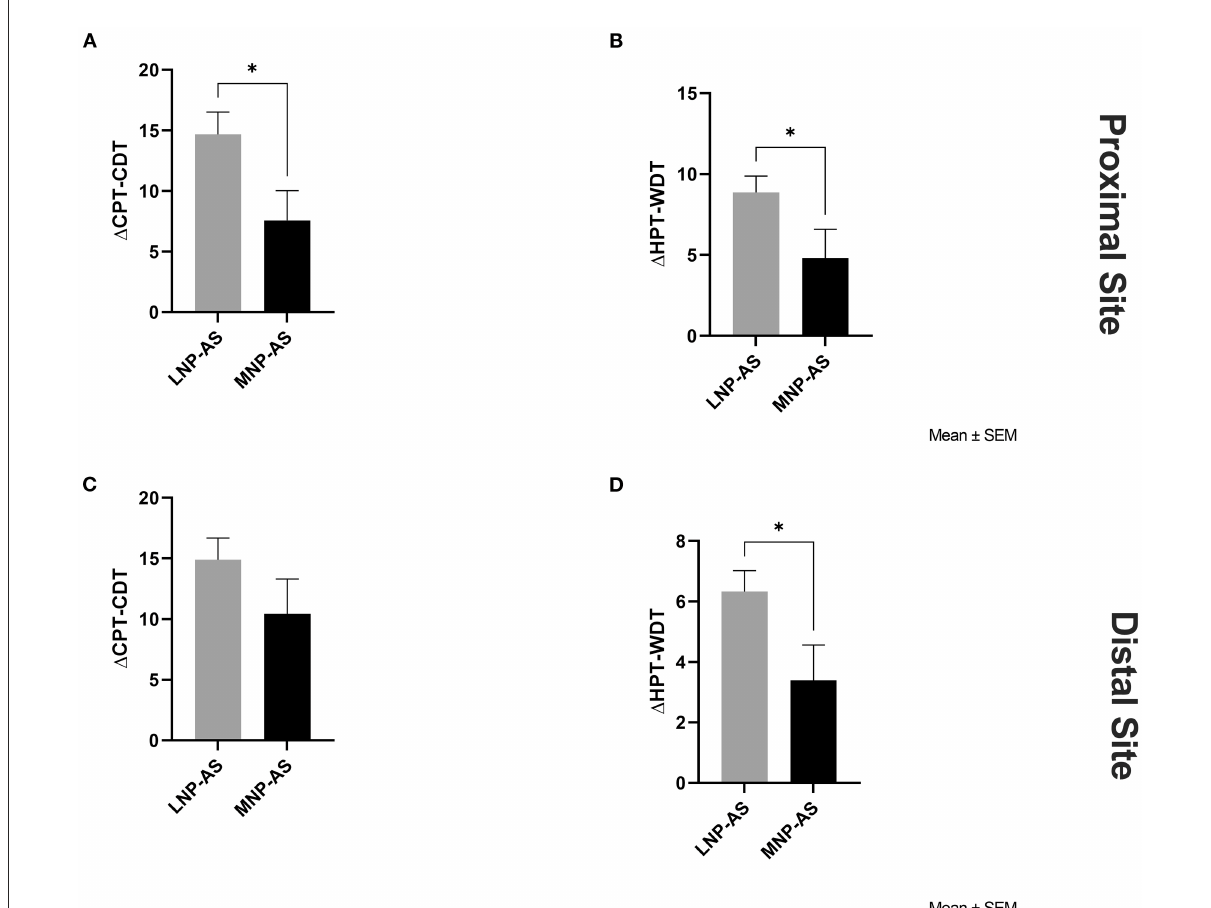
FIGURE2 Thermal somatosensory function obtained from QST. Significant group differences were found on the proximal site with respect to: (A) 1 CPT-CDT (delta cold pain threshold-cool detection threshold) and (B) 1 HPT-WDT (delta hot pain threshold-warm detection threshold); and on the distal site with respect to (D) 1 HPT-WDT between the LNP-AS (low or no neuropathic pain-anxiety symptoms) and MNP-AS (moderate neuropathic pain-anxiety symptoms). On the distal site, no group differences were found regarding (C) 1 CPT-CDT (delta cold pain threshold-cool detection threshold). * p <